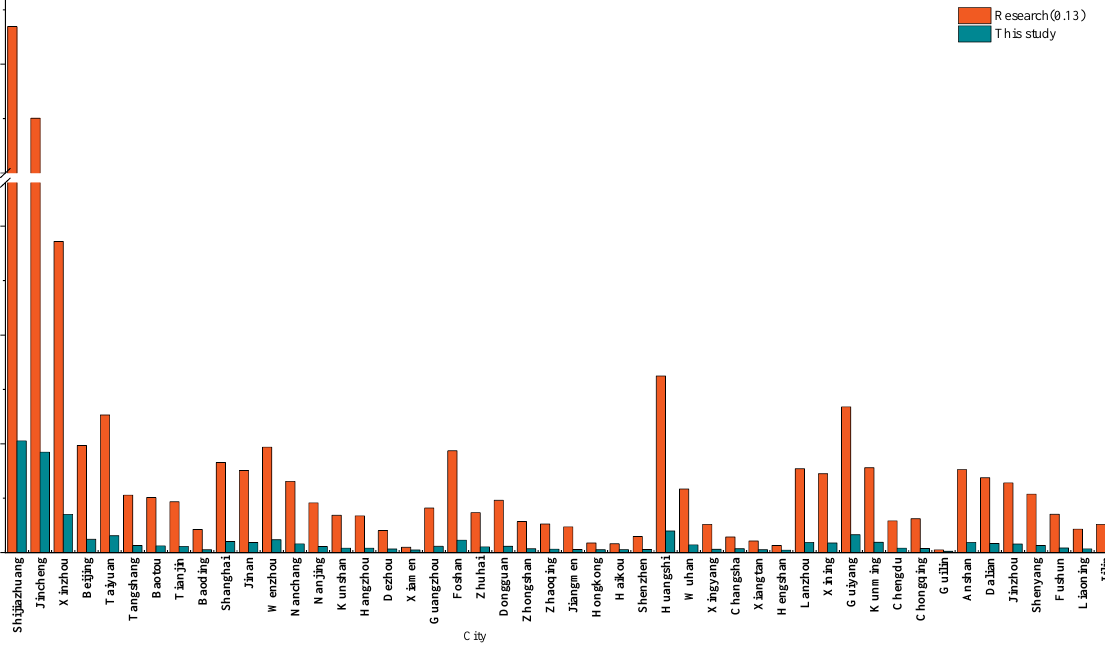
Figure 6. Comparison of Cr(VI) Concentrations in Various Cities.